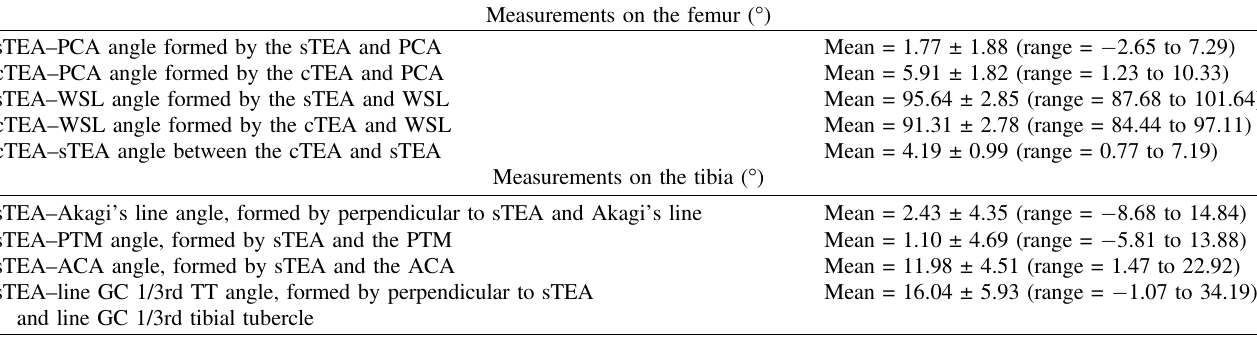
Table 2. Rotational relationships of sTEA with other axes on the femur and tibia. Measurements on the femur ( (cid:1)